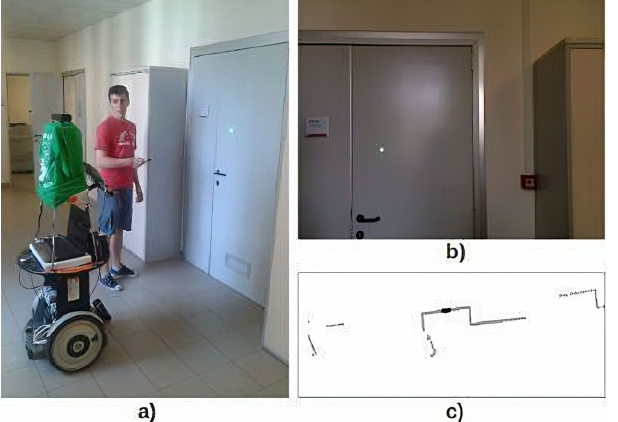
Figure 2. Adding semantic data to the map by tagging objects with a comercial laser pointer and giving a natural language description [40]. ( a ) The laser pointer is used to mark the object. ( b ) The point is detected in HSV color space. ( c ) The object is located in reference to the robot laser scan (represented by black